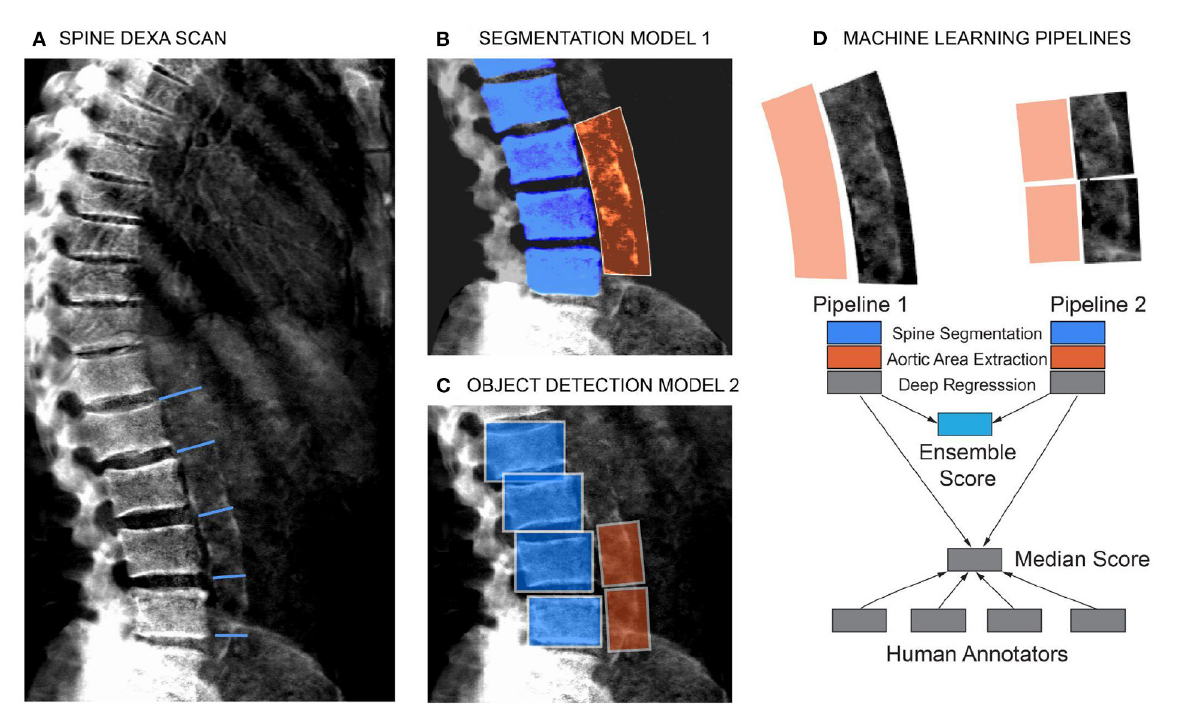
FIGURE2 Schematic of the machine learning pipeline to quantify AAC. Overview of the two independent machine learning pipelines used to quantify AAC. Lumbar vertebra detection (blue). And extracted aortic regions are highlighted in orange. An ensemble AAC score, combining predictions from both pipelines, performed the best on the validation dataset. (A) Representative DEXA scan (manual annotation score = 15). (B) Pipeline 1: Segmentation of the lower spine using U-Net architecture (blue). (C) Pipeline 2: Object detection–box segmentation of individual lumbar vertebrae (blue). (D) AAC scores are quantified using a neural network (NN) based regression against human-derived aortic calcification